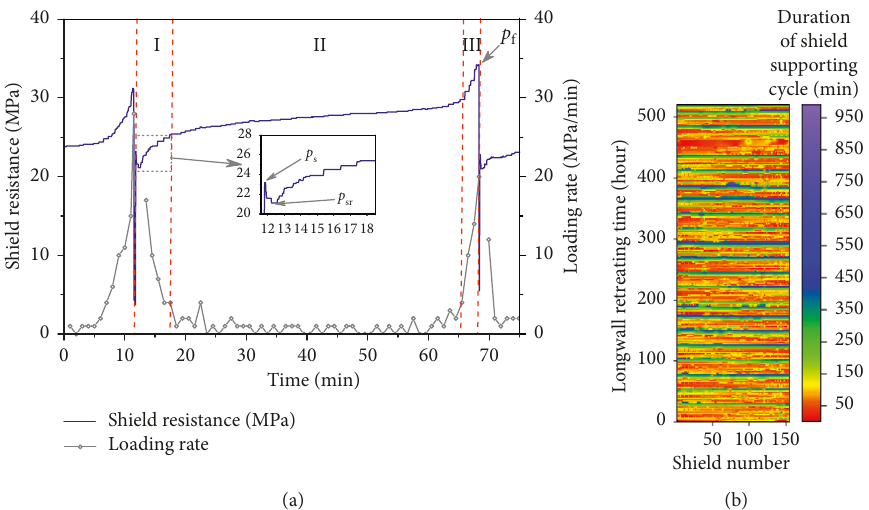
Figure 1: Shield supporting cycle. (a) Temporal evolution of shield resistance and loading rate in a typical shield-supporting cycle without yielding. The three periods are (I) initial period, (II) relatively stable period, and (III) cutting-influenced and neighboring shield advance period. (b) An example determination of shield-supporting cycle by SSRI (Panel LW22306 of Bulianta mine). p s , p sr , and p f denote setting pressure, revised setting pressure, and final pressure,